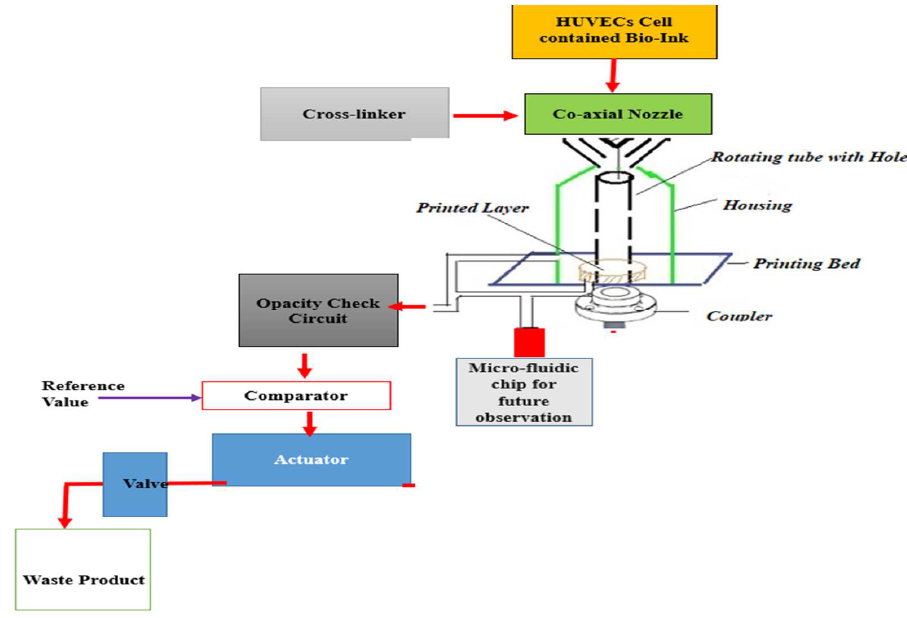
Figure 3. Schematic of 3D printer system for printing of serpentine channels. Table 6. Parameters used for 3D printing of serpentine channel.